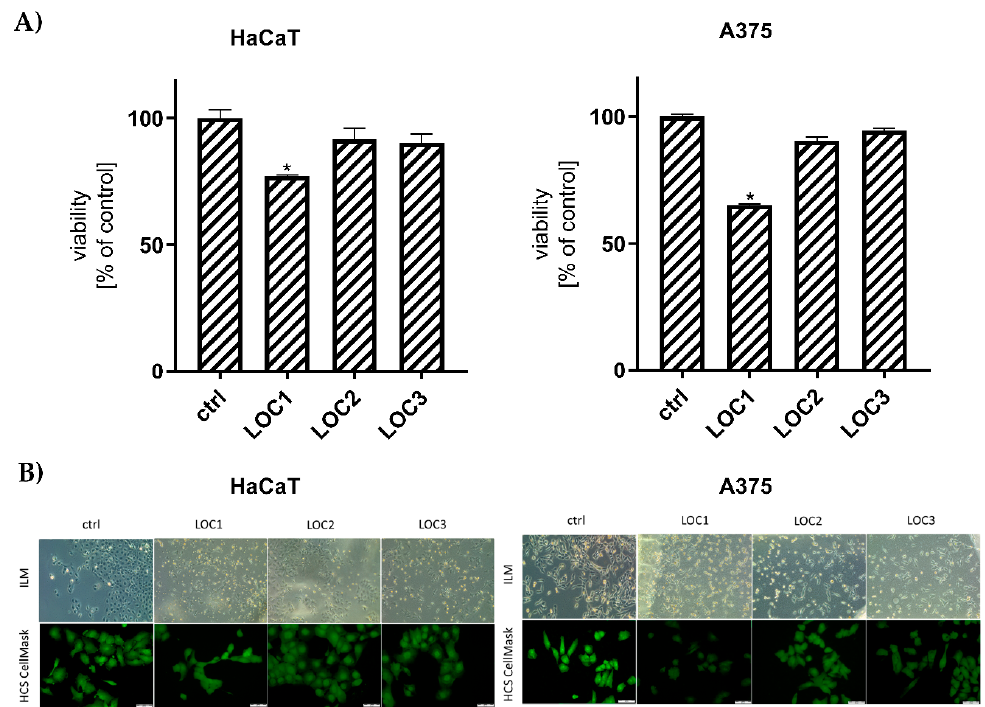
Figure 1. Evaluation of HaCaT and A375 cells viability ( A ) and morphology ( B ) after 24 h culturing on various Lab-on- a-Chip (LOC) (ILM: inverted light microscope); scale bars: 50 µ m. * Statistically significant differences in comparison to control cells ( p ≤ 0.05).